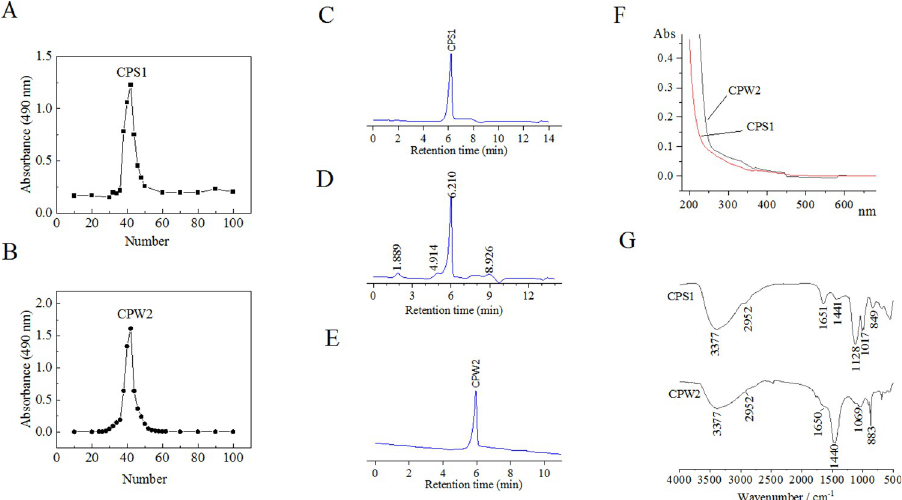
Fig 2. DEAE-Sepharose CL-6B elution profiles (A-B), HPSEC chromatograms (C-E), UV spectrum (F), and FTIR spectra (G) of CPS1 and CPW2.